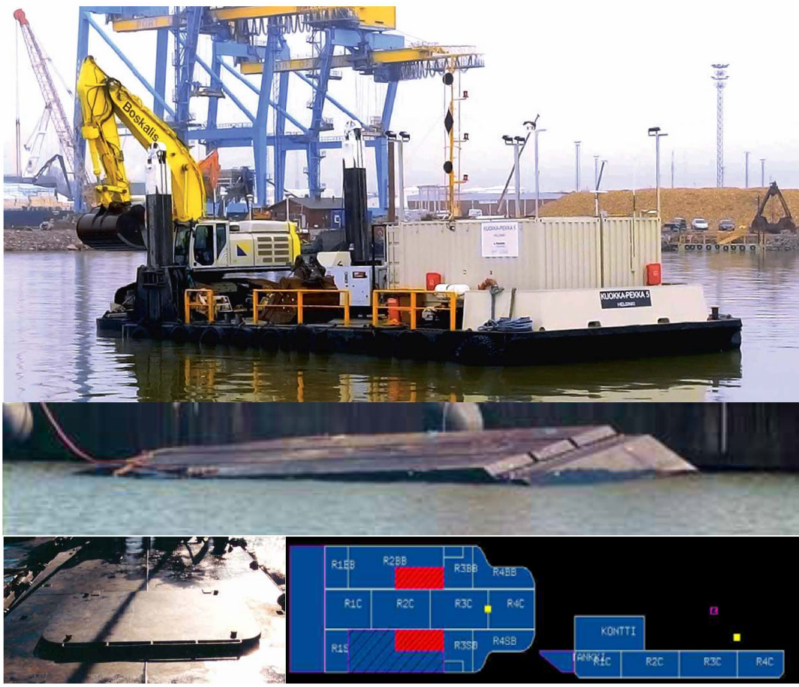
Figure 1. Dredger “Kuokka Pekka 5” capsized. GRT 104, Length 21.0 m, Breadth 9.4 m, Draught 1.7 m.